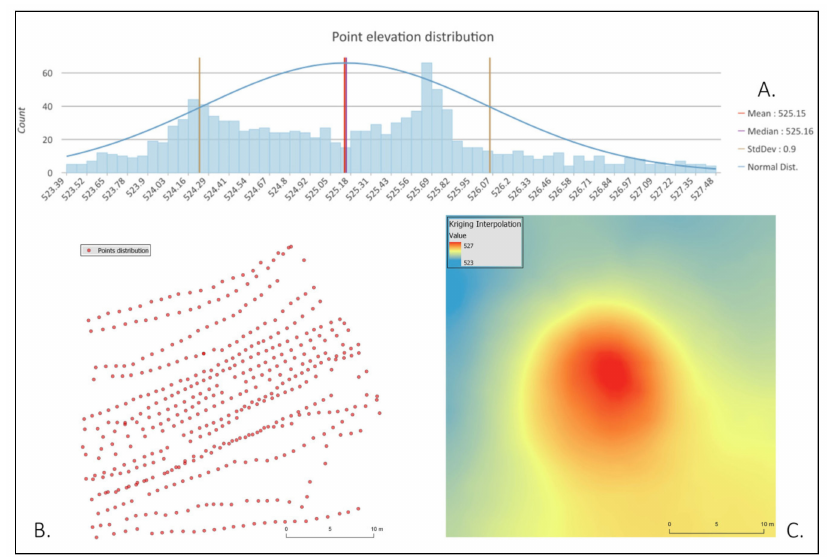
Figure 5. ( A ) Elevation distribution in the dataset; ( B ) Measured points in the field; ( C ) Interpolation. In the case of the M3 mound, two complementary geophysical methods (Figure 6) were used: a passive one taking geomagnetic measurements and an active one taking geoelectric measurements (electrical resistivity